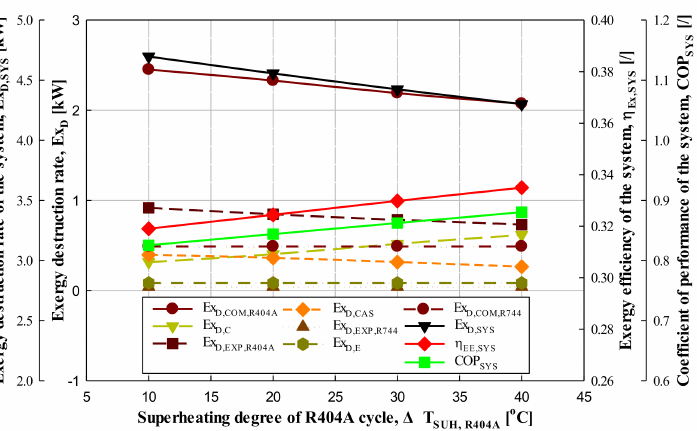
Figure 12. Performance analysis results with respect to superheating degree in the R404A cycle of the